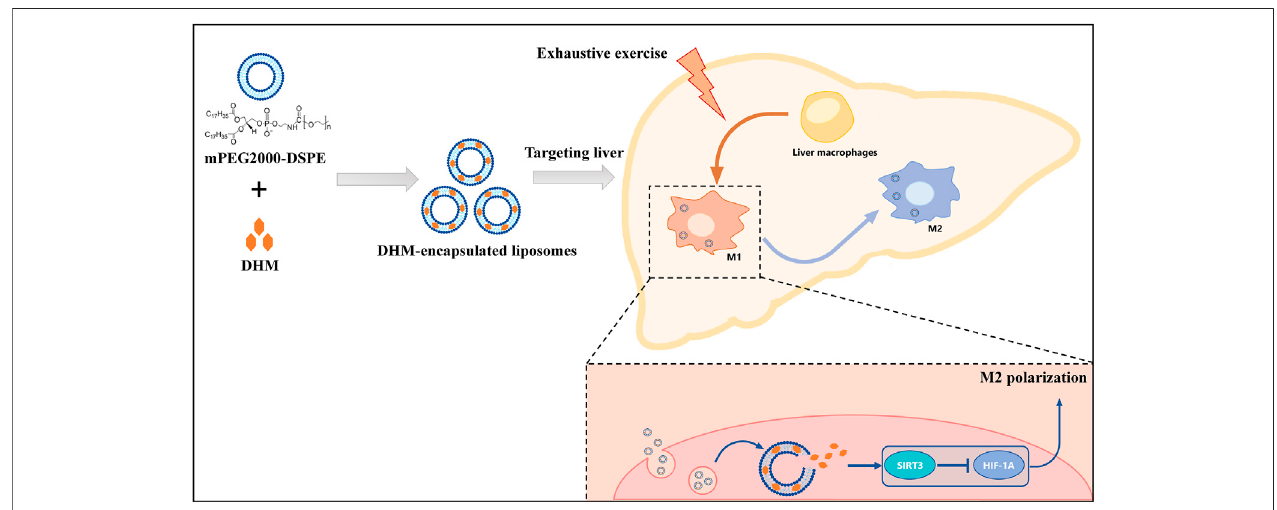
FIGURE 7 | Schematic diagram. The preventive and therapeutic effect of DHM-Lipo against EE-induced liver injury occurs through the regulation of macrophage polarity from the M1 to M2 type via the SIRT3/HIF-1 α pathway.